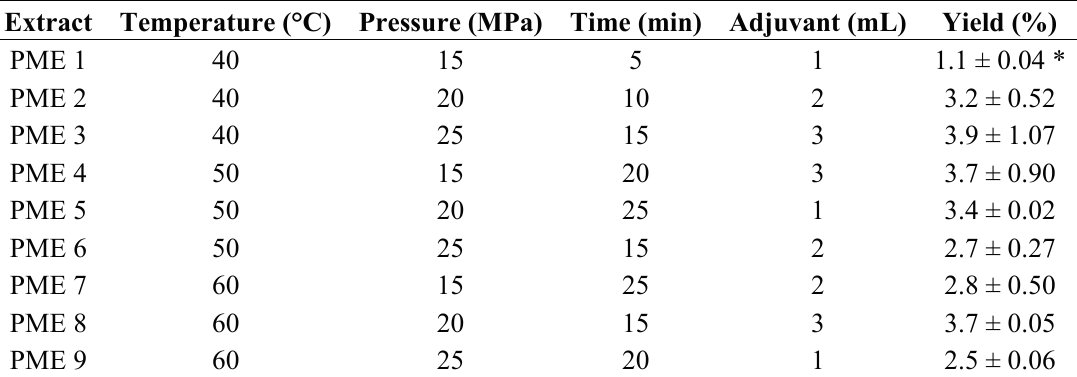
Table 2. Conditions and the yields of supercritical fluid extraction for Pinus morrisonicola extract